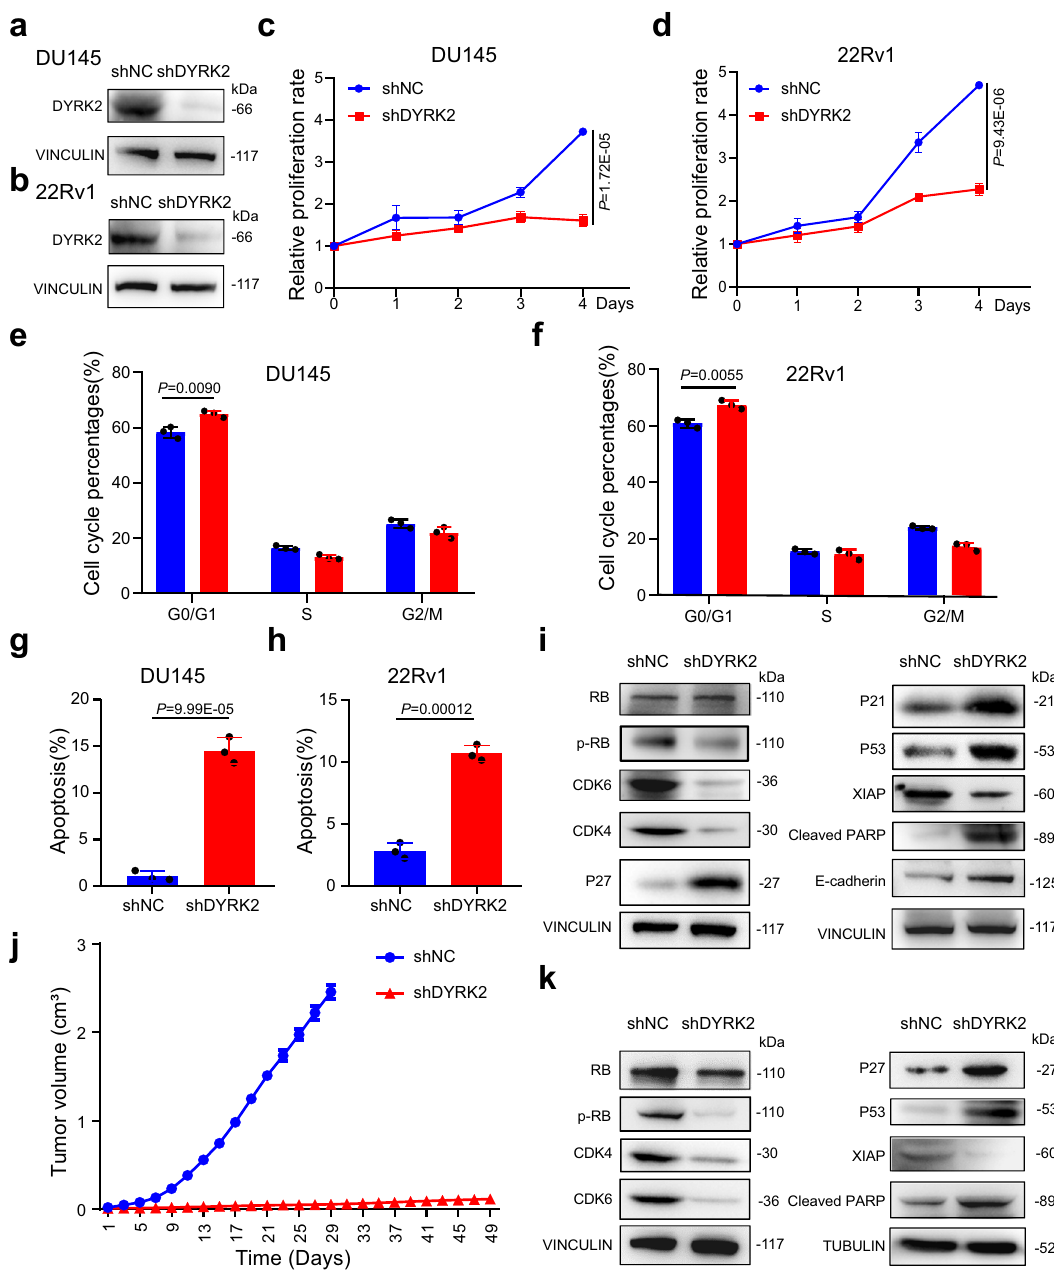
Fig. 2 Knock-down of DYRK2 inhibited PCa in vitro and in vivo. a , b Protein level of DYRK2 in DU145 shNC/shDYRK2 ( a ) and 22Rv1 shNC/shDYRK2 ( b ) cells. c , d Cell viability of DU145 shNC/shDYRK2 cells ( c ) and 22Rv1 shNC/shDYRK2 cells ( d ) during a 5-day course. Unpaired two-tailed Student ’ s t test. Error bar, mean ± SD, n = 3. e , f Cell cycle phase distribution of DU145 shNC/shDYRK2 cells ( e ) and 22Rv1 shNC/shDYRK2 cells ( f ) determined by fl ow cytometry. Unpaired two-tailed Student ’ s t test. Error bar, mean ± SD, n = 3. g , h Apoptosis of DU145 shNC/shDYRK2 cells ( g ) and 22Rv1 shNC/shDYRK2 cells ( h ) determined by fl ow cytometry. Unpaired two-tailed Student ’ s t test. Error bar, mean ± SD, n = 3. i Western blotting analysis of indicated proteins in DU145 shNC and shDYRK2 cells. j , k BALB/c nude mice were implanted subcutaneously with DU145 shNC ( n = 6) and shDYRK2 ( n = 10) cells. Tumor volume of mice ( j ) was measured every two days. Error bar, mean ± SD. The shNC group was euthanatized at 29 th day and shDYRK2 group was euthanatized at 49 th day. Tumor tissues of mice treated with DU145 shDYRK2 and shNC cells were taken out, then the total proteins in the tumor were extracted and subjected to the western blotting analysis of indicated proteins ( k ). Source data are provided as a Source Data fi